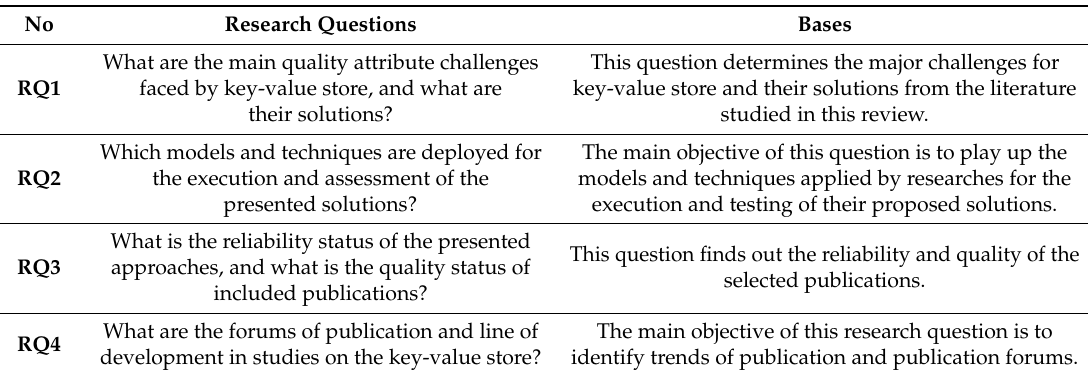
Table 2. Research questions and their